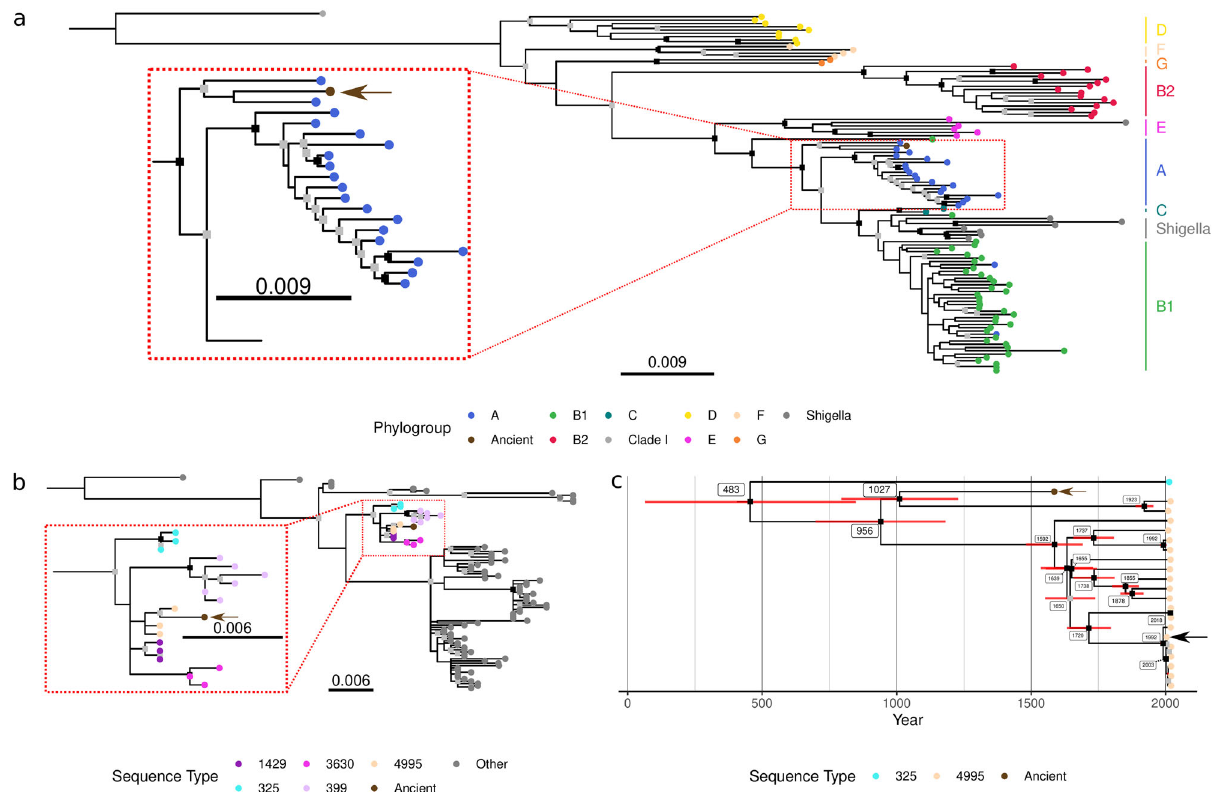
Fig. 3 Maximum likelihood SNP phylogeny of E. coli . a The global phylogeny with bootstrap values and phylogenetic groups with E. coli EC42405 as the out-group. b Phylogeny of the reduced subgroup A0 as de fi ned by the Clermont genotype ( + - - -) 61 . Tip points represent the sequence type of the strain. IAI1 was the out-group of the phylogeny. c Phylogeny of the ST4995 strains. Red rectangles represent the 95% con fi dence interval for the topology; labels indicate the median date of divergence. The evolutionary rate for the phylogeny was 2.555 × 10 − 6 [1.567× 10 − 6 , 3.992 × 10 − 6 ] subs/site/year. CFSAN051544 was the out-group. The brown arrows indicate the position of the ancient genome.